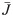
Constraints on total synaptic weights.(a-c) An upper bound on the total synaptic weight. (d-f) A fixed total synaptic weight. (a) For two inputs with a total synaptic weight of at most J¯, the synaptic weights must live in the area under a line segment from (0,J¯) to (J¯,0) (a regular 1-simplex). (b) For three inputs, the synaptic weights must live in the volume under a regular two-simplex. (c) Volume of the K − 1 simplex as a function of the number of presynaptic partners, K, for different maximal net weights J¯. (d) For two inputs with a total synaptic weight fixed at J¯, the synaptic weight configurations must be on the line segment from (0,J¯) to (J¯,0). (e) The solution space for the fixed net weight constraint with three inputs is an equilateral planar triangle (a regular 2-simplex). (f) Surface area of the regular K − 1 simplex as a function of the number of presynaptic partners, K, for different net synaptic weights J¯.